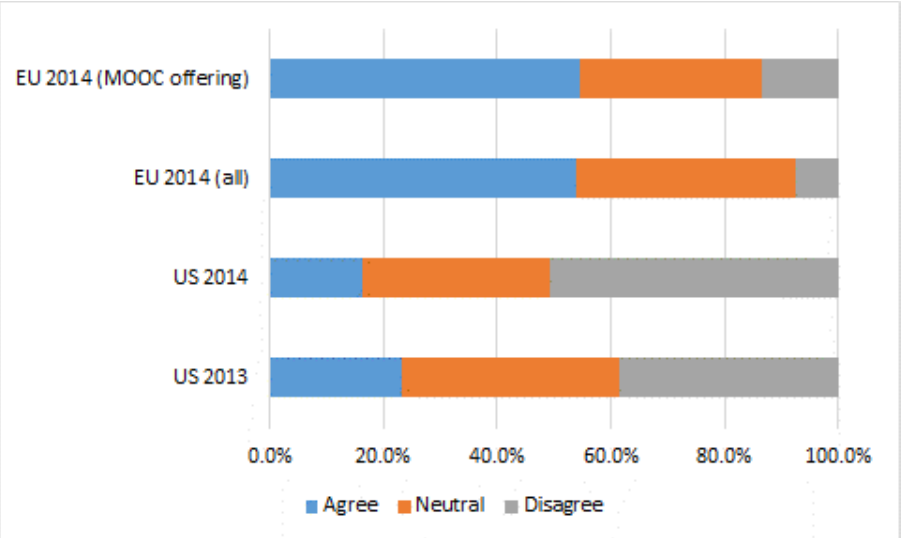
In contrast to U.S., the European HEIs seem to disagree with the statement that “Credentials for MOOC completion will cause confusion about higher education degrees.”